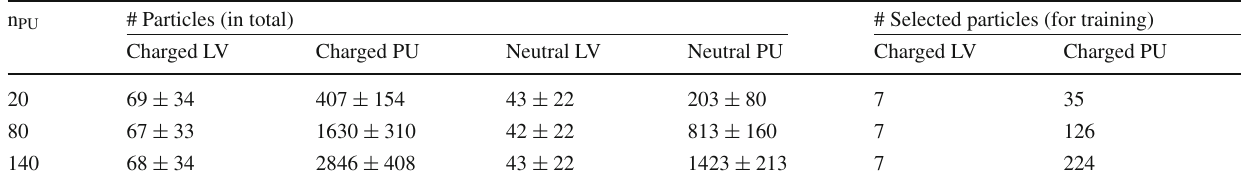
Table 2 The first four columns include the mean and variance of four types of particles under different pileup conditions per graph. The last two columns indicate the number of charged particles being randomly selected for training per graph in one epoch n PU # Particles (in total) # Selected particles (for